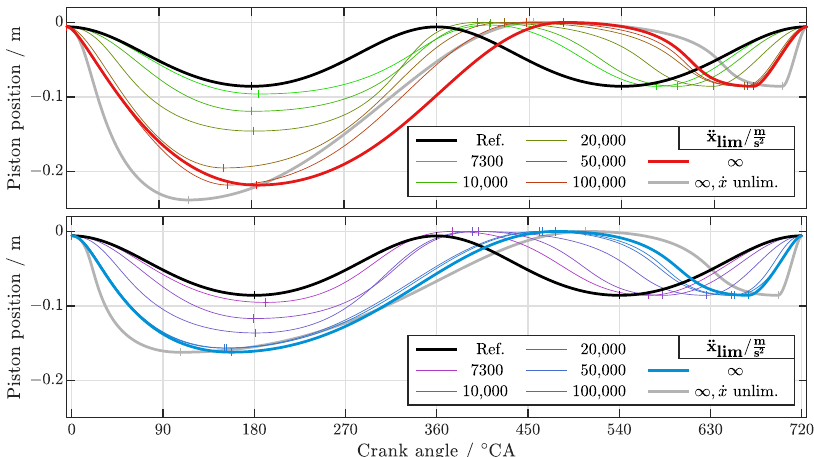
Figure 4. Optimized piston trajectories at full ( top ) and part ( bottom ) load operation for different maximum piston acceleration